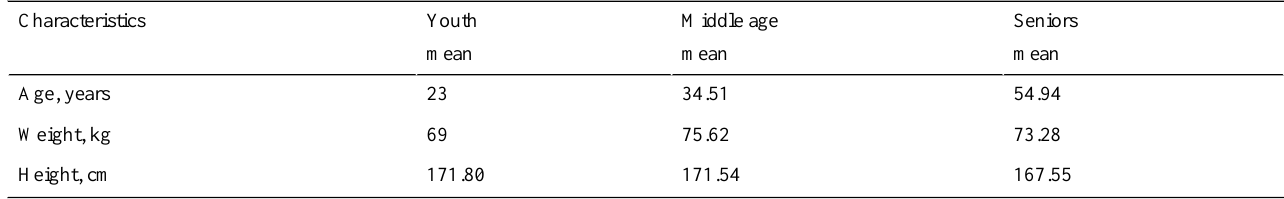
Table 2. Characteristics of the subsets of adult